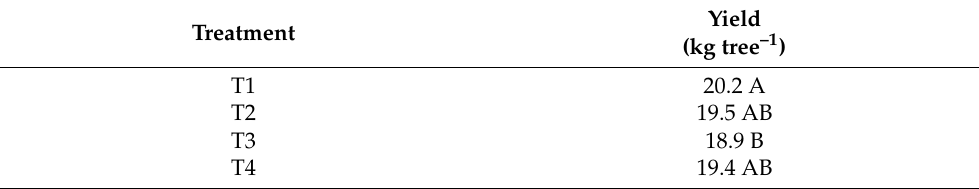
Table 5. Influence of the treatment on olive yield per tree on average, during a 14-year period.